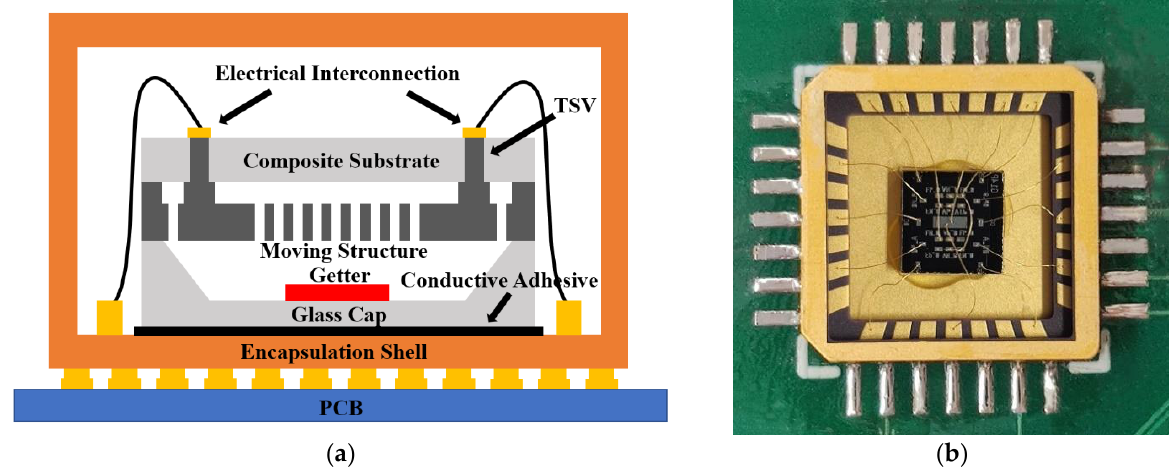
Figure 2. ( a ) Schematic illustration of the TFG architectures and ( b ) a photograph for the ceramic carrier of the vacuum- packaged MEMS TFGs.